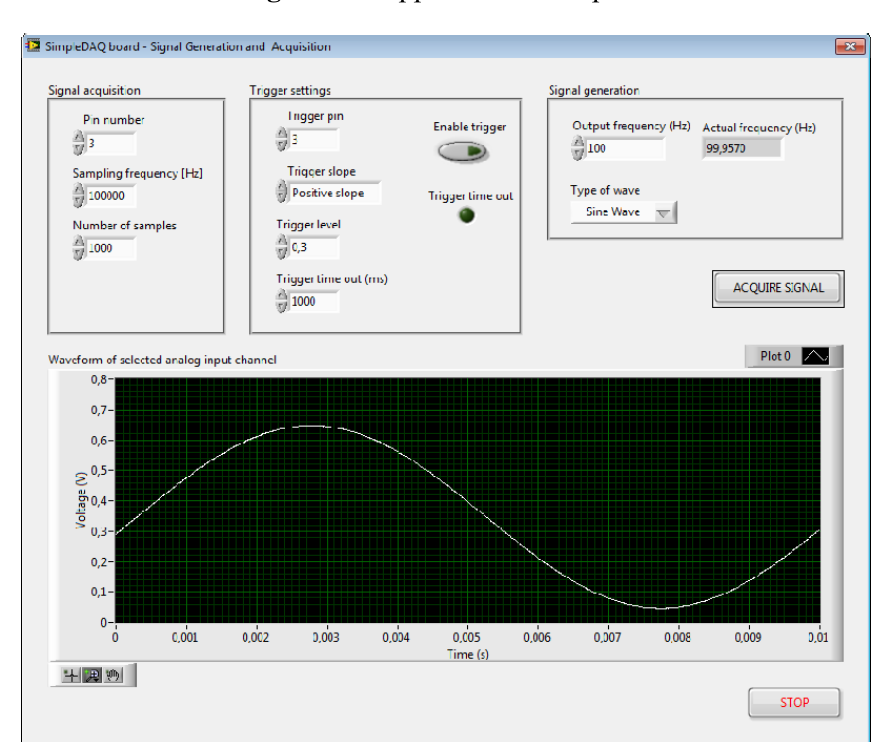
Figure 14. Application front